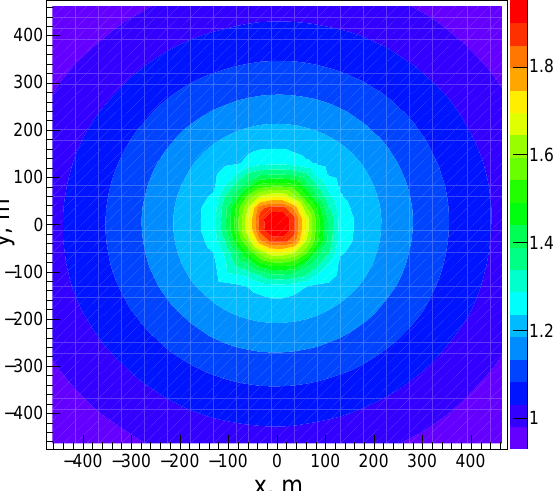
Figure 20. The ratio of sample averaged Cherenkov photons distribution for the nuclear pair pro- ton/Fe for the CORSIKA atmosphere model 11. Bin size 50 m × 50 m. Primary protons with 10 PeV energy. Zenith angle 15 ◦ . Sample volume 30